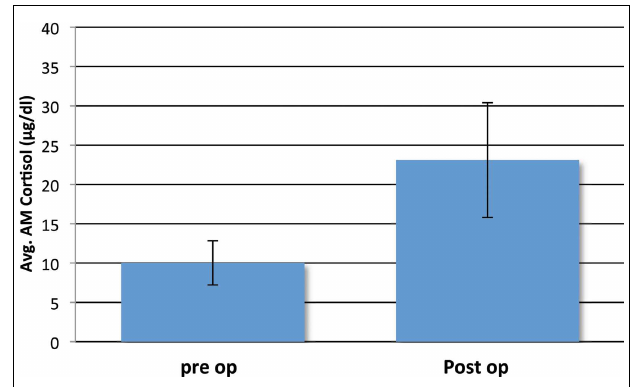
FIGURE 2 | Mean pre- and post-operative serum cortisol levels ( µ g/dl) in the study cohort of non-Cushing’s patients with pituitary pathology that underwent surgeries without stress-dose steroid coverage. Four patients with missing pre-operative cortisol data were excluded. Error bars indicate standard deviation.